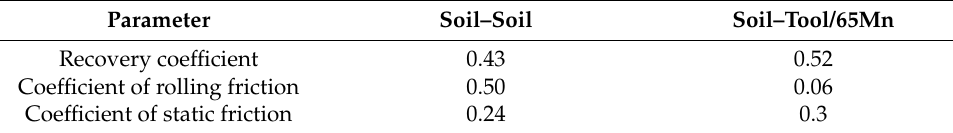
Table 2. Simulated contact parameters.